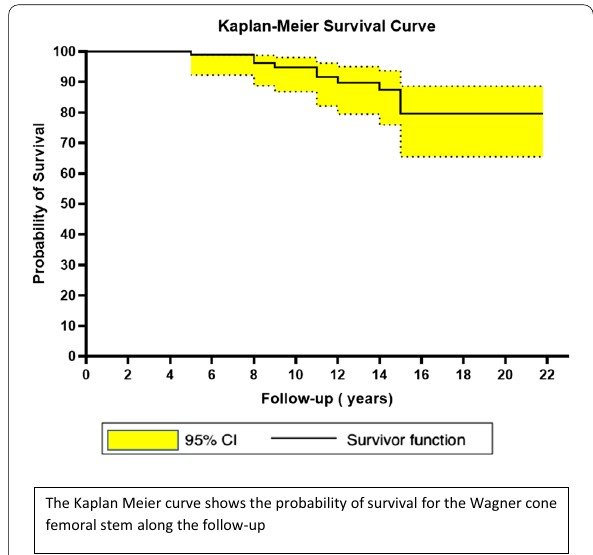
TheKaplan Meier curve shows the probability of survival for the Wagner cone femoral stem along the follow-up Fig. 2 The Kaplan–Meier curve: survival rate of 99.2% at 5 years, 95.1% at 10 years, and 81.3% at 20